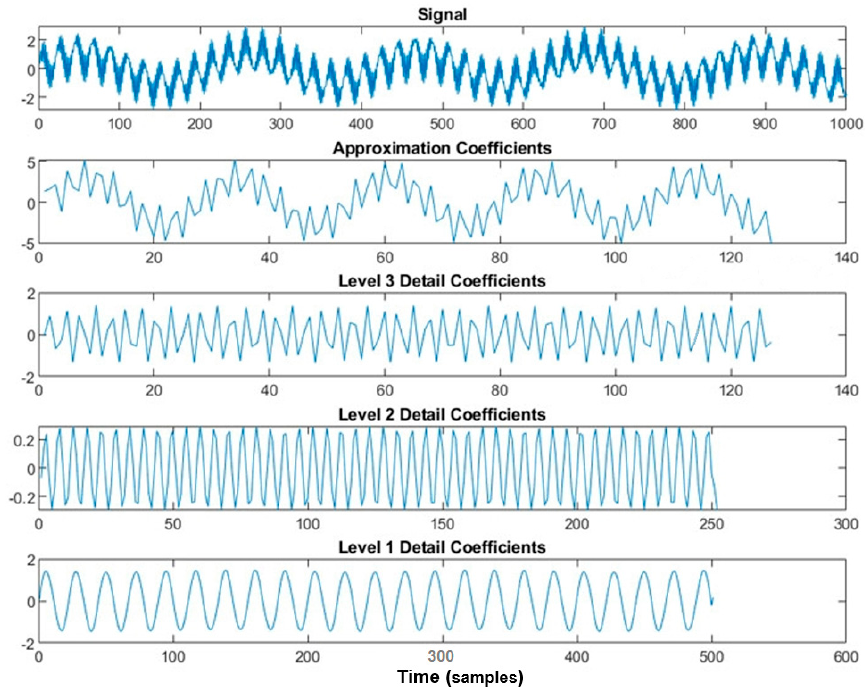
Figure 9. Signal decomposition on three levels of resolution using MATLAB.